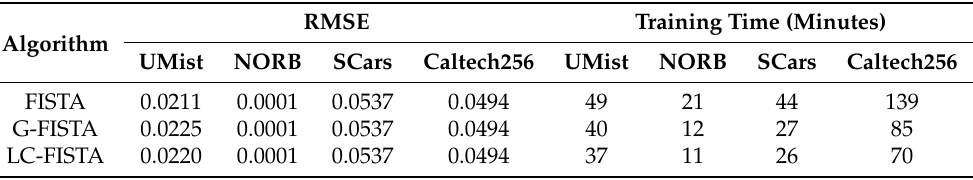
Table 8. The performance of each algorithm for the λ chosen in Table 3.